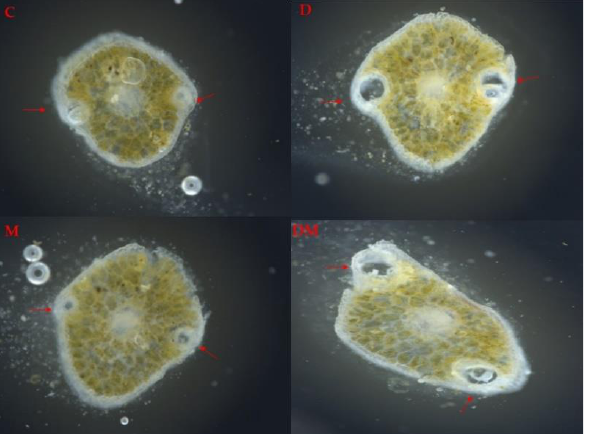
Figure 6. Representative Picea glauca needle cross sections (60 µm) under inverted light microscopy after treatment with drought (D), MeJA (M), drought + MeJA (DM) and untreated control (C). Resin ducts are indicated with arrows.